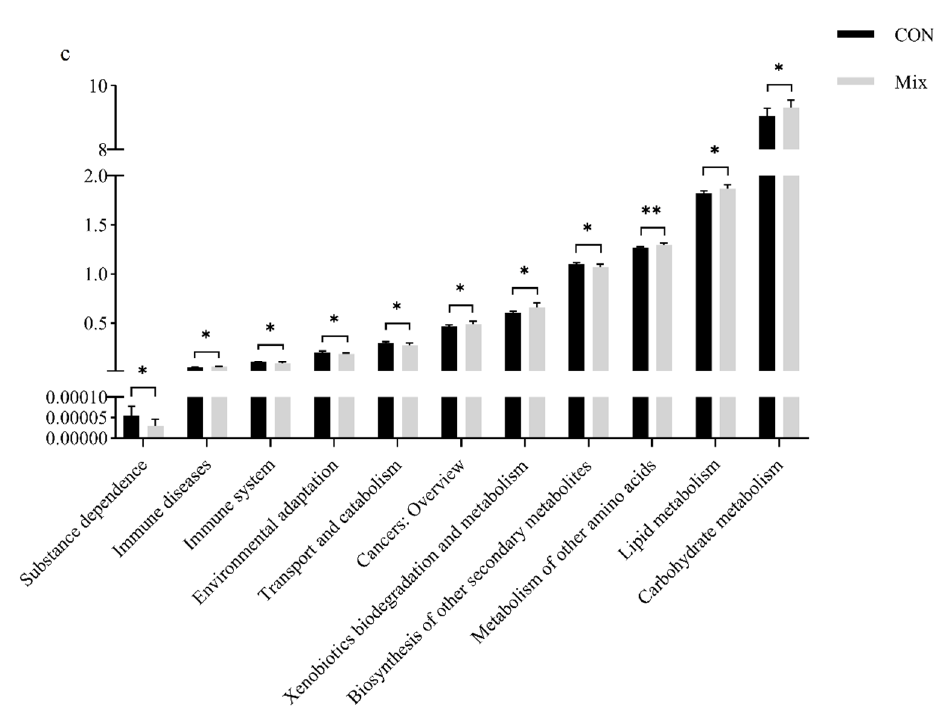
Figure 9. Composition and differential analysis of KEGG metabolic pathways. ( a ) Composition and differential analysis of the CON-CGA KEGG metabolic pathway. ( b ) Composition and differential analysis of the CON-PF KEGG metabolic pathway. ( c ) Composition and differential analysis of the CON-Mix KEGG metabolic pathway. All bar charts show means ± SD, * = p < 0.05; ** = p < 0.01.